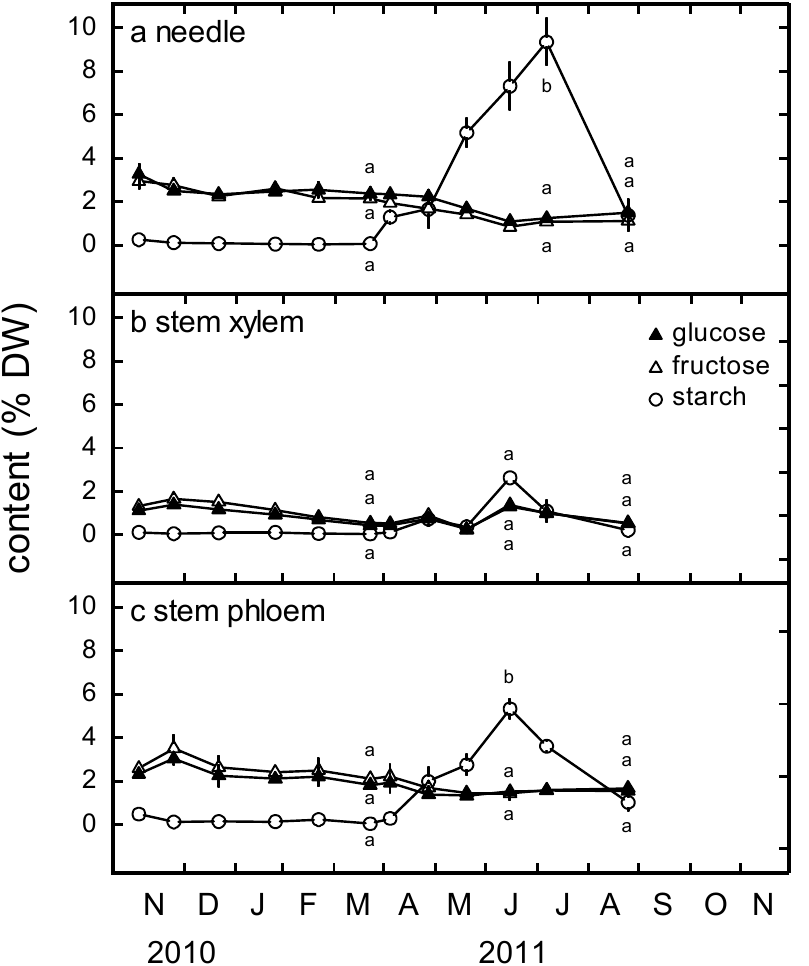
Figure 5. Course of glucose, fructose, and starch content. Carbohydrate contents (% of dry weight) in ( a ) needles, ( b ) stem xylem, and ( c ) stem phloem. Mean ± SE. Different letters indicate significant differences between measurements on 22 March, 24 August, and the sampling date of the highest values within this period.